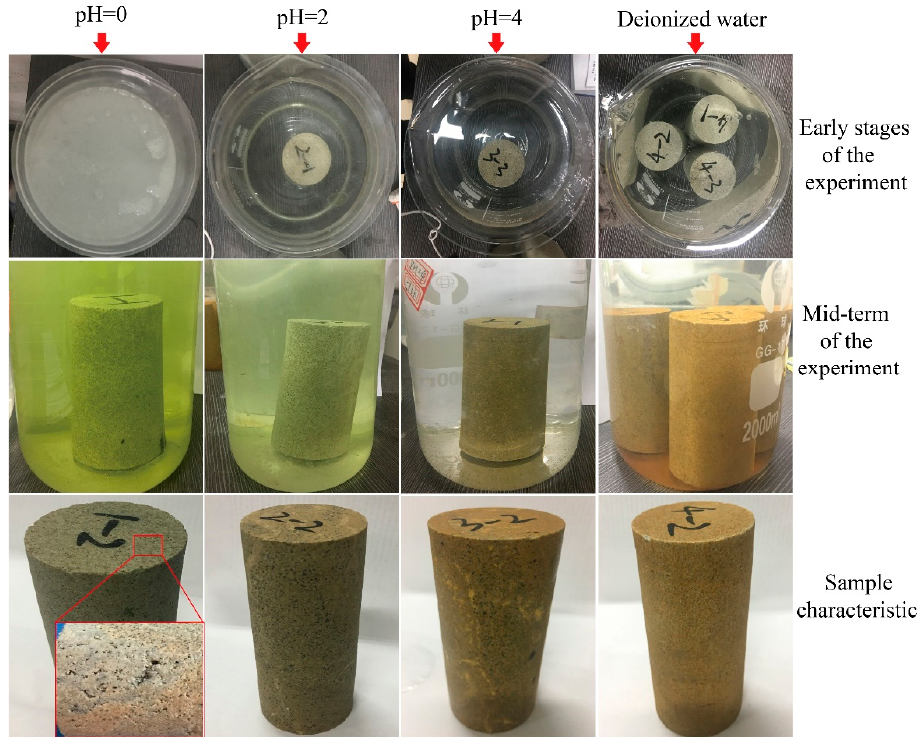
Figure 6. Phenomenon of lamprophyre samples in pickling experiment.